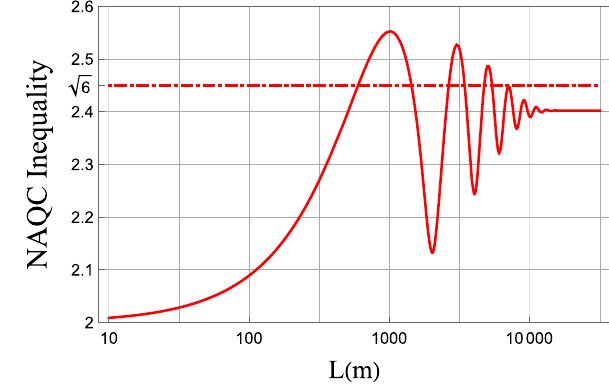
= 3 . 3 × 10 − 6 m . The L-axis is in logarithmic scale. On the right σ x panel is shown the NAQC inequalities for this survival probability. The dot-dashed horizontal line is the bound of the NAQC × 10 − 3 eV 2 and 0 . 11